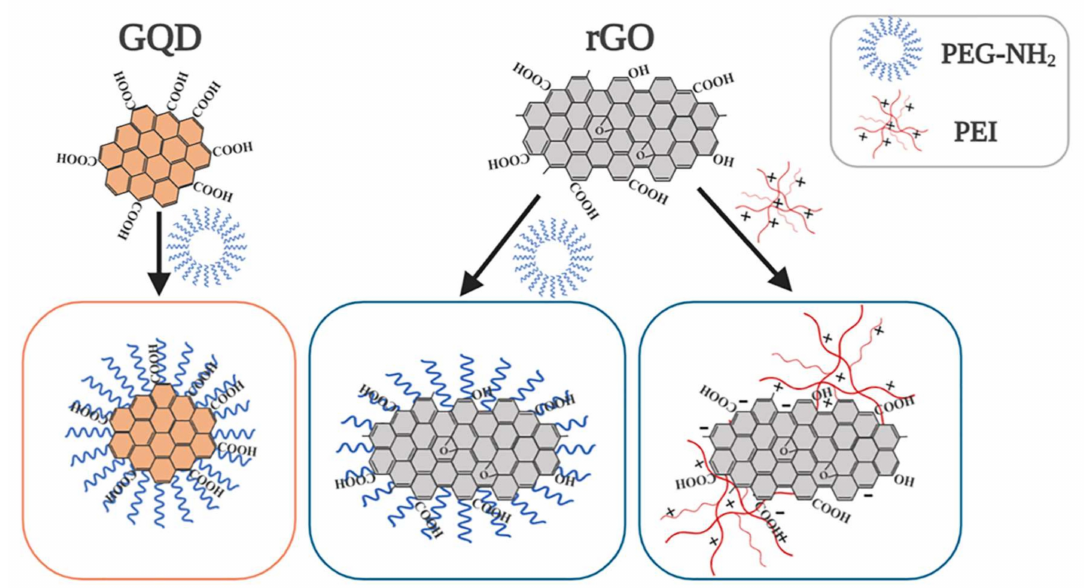
Figure 1. Schematic illustration of the modification of graphene quantum dots (GQD) and reduced graphene oxide (rGO). Amino-polyethylene glycol (PEG) is covalently coupled to carboxyl or hydroxyl groups present on GQD and rGO, while polyethyleneimine (PEI) is electrostatically adsorbed to rGO. “ + ” and “ − ” stand for positive and negative charge, respectively. Created with